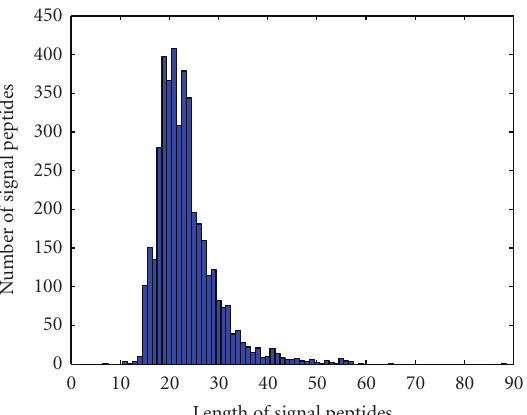
Figure 2: A histogram to show the distribution of signal peptides with their length in the 4,184 secretory proteins constructed in this study. Of the 4,184 proteins, 894 humans, 338 plants, 1,435 animals, 635 eukaryotic, 269 Gram-positives, and 613 gram-negatives.